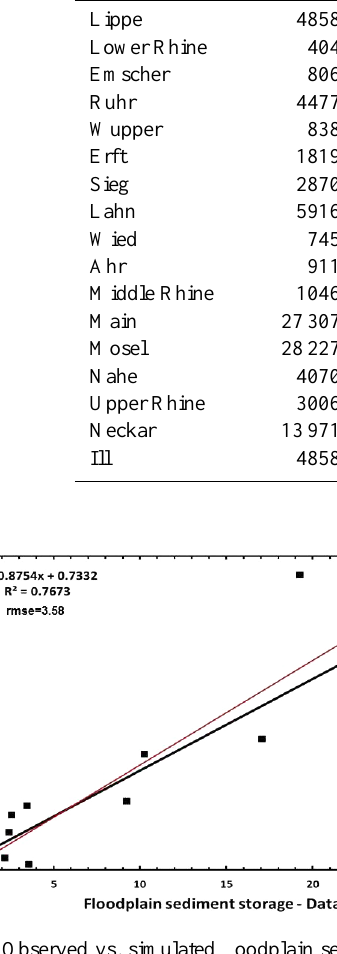
Figure 4. Observed vs. simulated floodplain sediment storage for Rhine sub-catchments. The values are in percent (actual storage di- vided by the sum times 100). Data on the observed sediment storage are taken from Hoffmann et al. (2007). RMSE is the root-mean- square